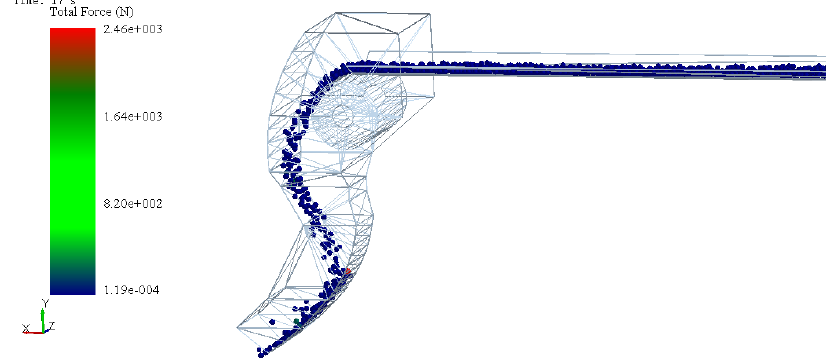
Figure 3. Simulation diagram of impact force.